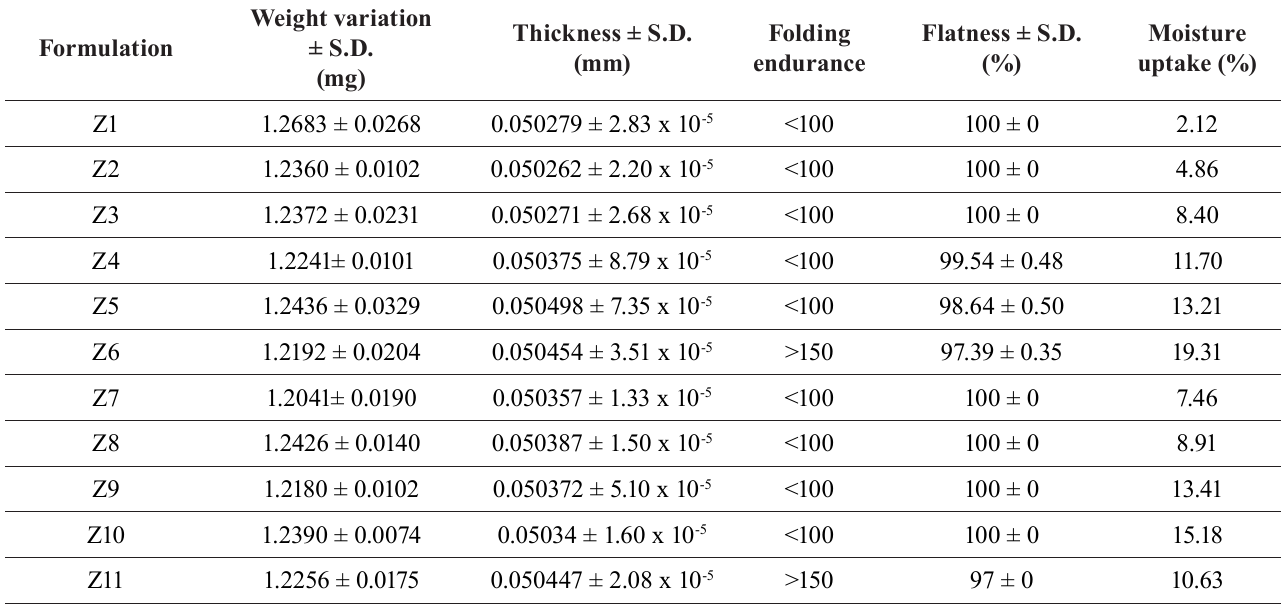
Table II. P hysicochemical evaluation of matrix transdermal formulations of Metoclopramide.